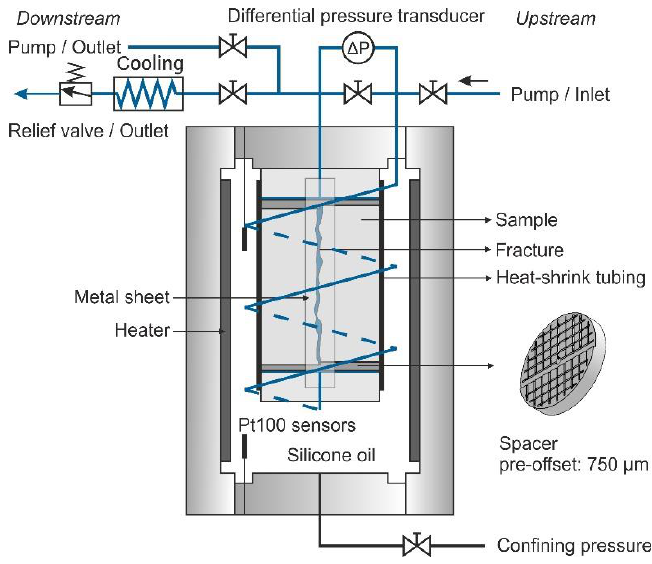
Figure 2. Schematic illustration of the experimental apparatus used for the flow-through experiment. The assembled sample is mounted in a hydrostatic confining pressure vessel and isolated by heat-shrink tubing. The lower and upper sample ends are connected to syringe pumps (ISCO 260D), and a relief valve placed in parallel at the downstream side is used for effluent sampling.